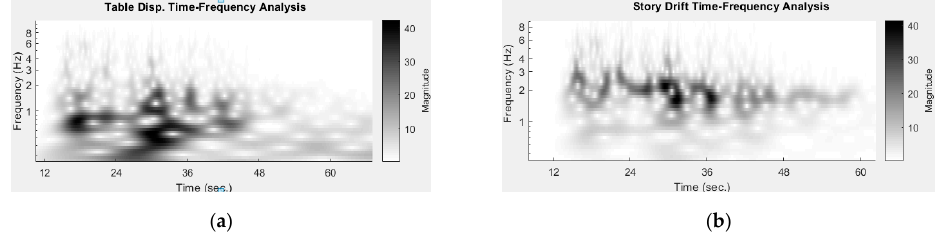
Figure 24. Time–frequency analysis of ground and roof displacements. Image analysis measurement shows the structural frequency variation, indicating a certain level of structural failure. ( a ) Foundation response( b ) Roof response.